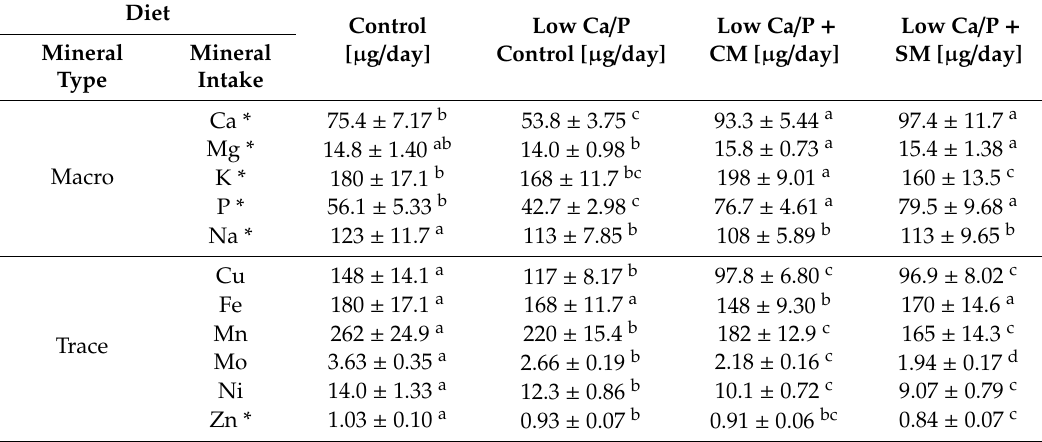
Table 3. Mineral intake per day of rats fed on di ff erent milk diets ˆ